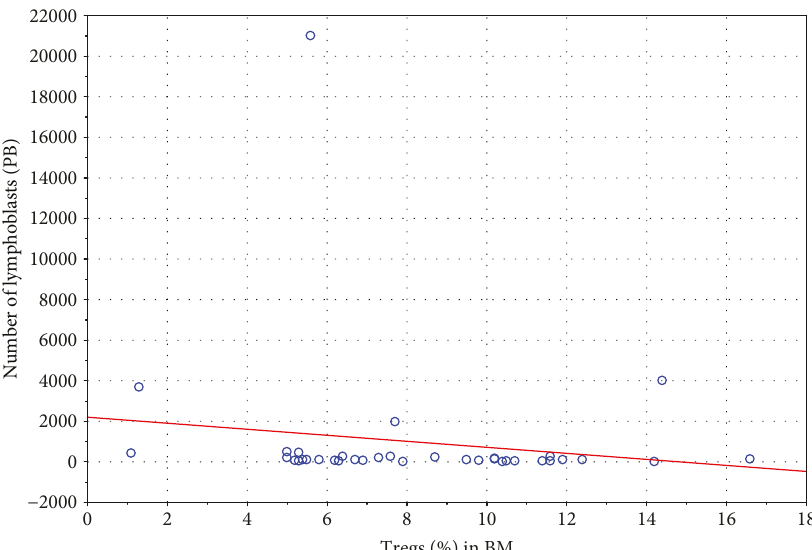
Figure 7: Correlation between blasts level on the 8th day of steroid therapy in PB with the percentage of Tregs in BM at the moment of diagnosis ( R = – 0 36